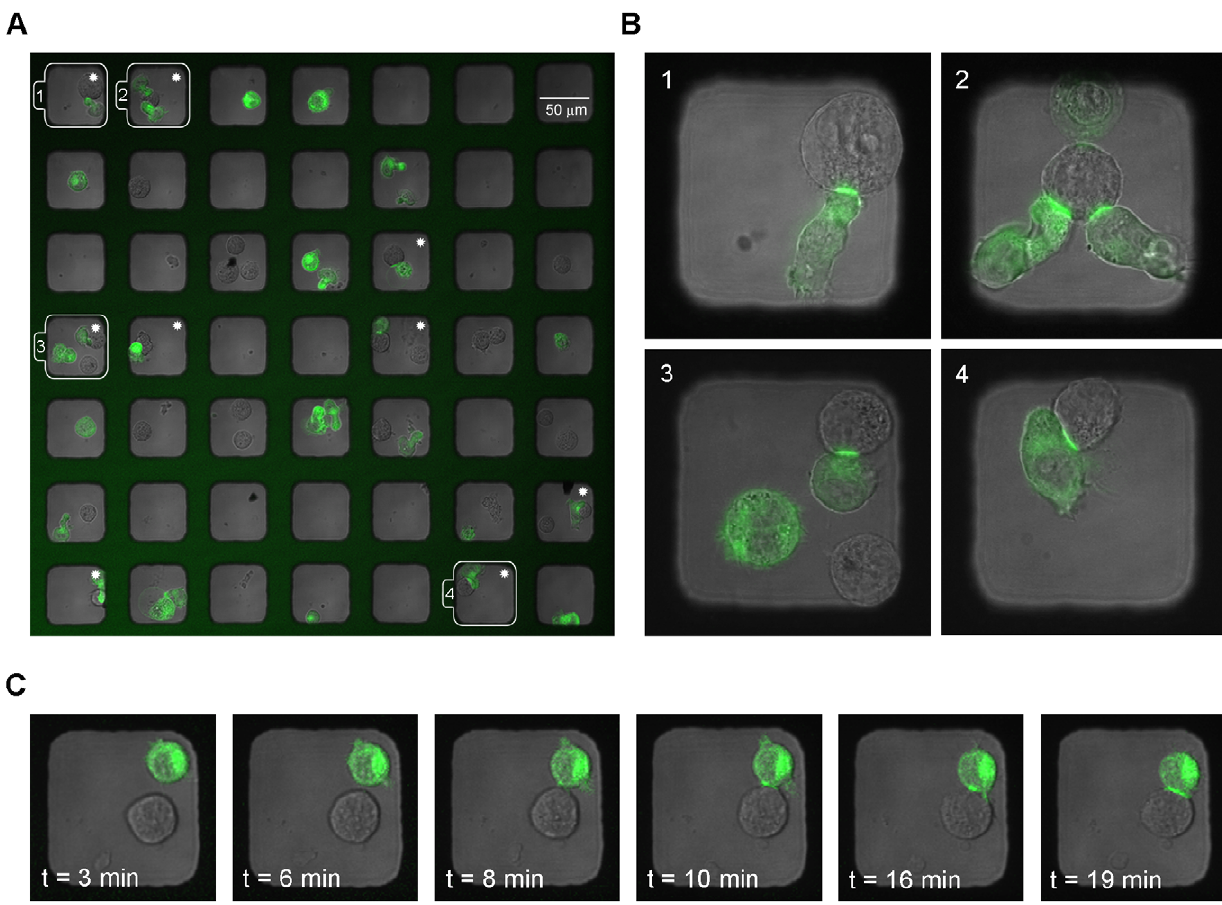
Figure 7. High-resolution imaging of immune synapse formation in microwells. 221/Cw6-GFP target cells (green) were seeded together with the unstained NK cell line YTS/KIR1, and the chip was imaged for synapse formation over time. Inhibitory immune synapse formation can be seen by localized accumulation of HLA-Cw6-GFP at the zone of intercellular contact. (A) Small part of the chip where inhibitory immune synapses are seen in 9 wells (indicated by white stars). After approximately 1 hour, immune synapses could be seen in nearly 20% of the wells shown (9/49), and in 81% (9/11) of the potential wells containing both cell types. (B) Four wells were chosen for high-resolution imaging (63 6 magnification) as indicated by numbers 1–4. (C) Time-lapse sequence showing the dynamics of synapse formation in a single well containing one NK and one target cell. Here t=0 refers to the time point when the YTS/KIR1 cell landed on the bottom of the well. Images shown are representative from 4 individual experiments.